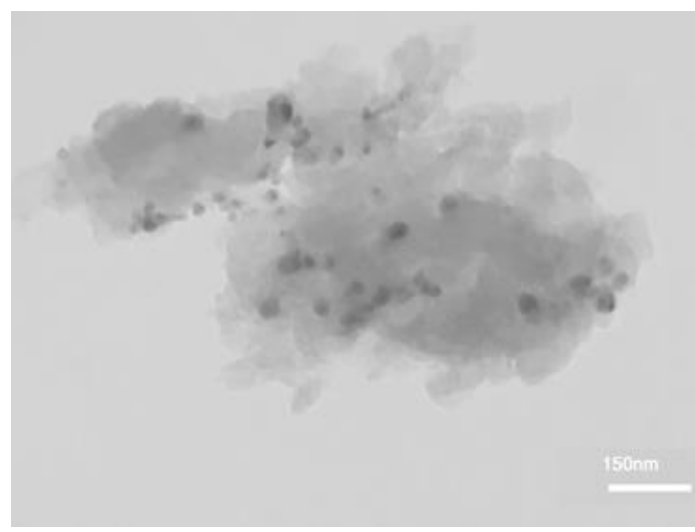
Figure 10. TEM image of the recycled catalyst after 5 reaction runs.